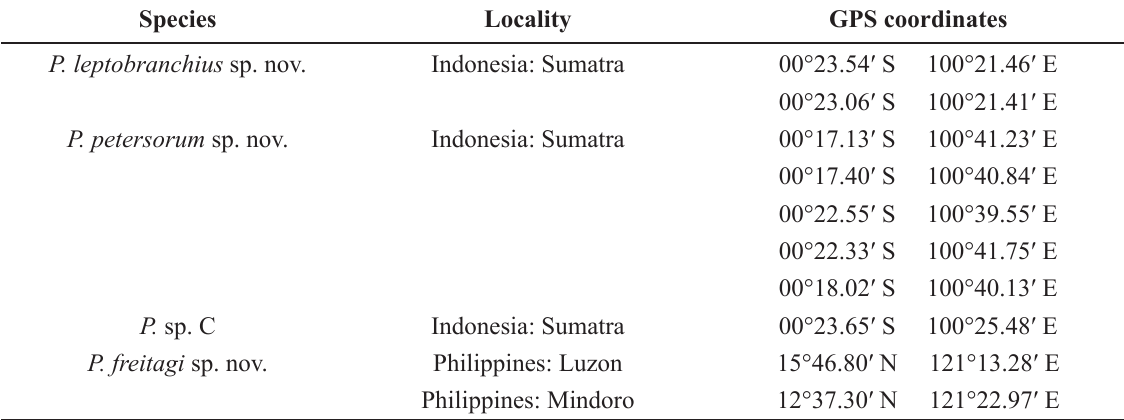
Table 2. GPS coordinates of the locations of examined specimens of Procerobaetis gen. nov.